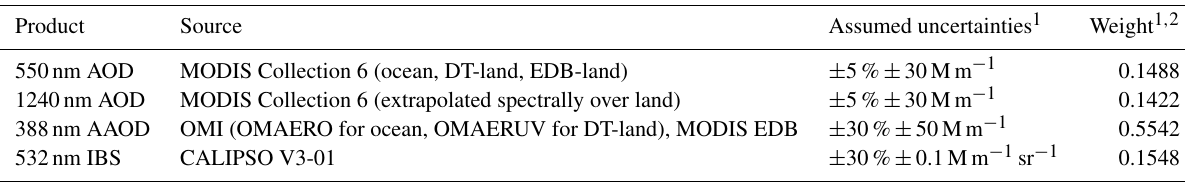
Table A1. Datasets currently used for global MODIS–OMI–CALIOP (MOC) retrievals of aerosol radiative properties (Redemann et al., 2019); DT: Dark Target; EDB: Enhanced Deep